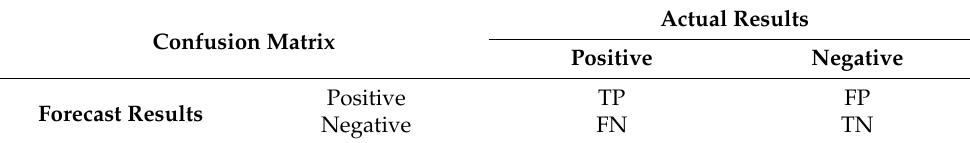
Table 4. Confusion matrix of binary classification problem.